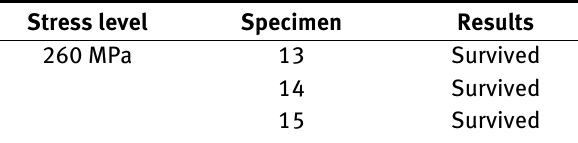
Table 5: Results of verification test for run-out at 1E7